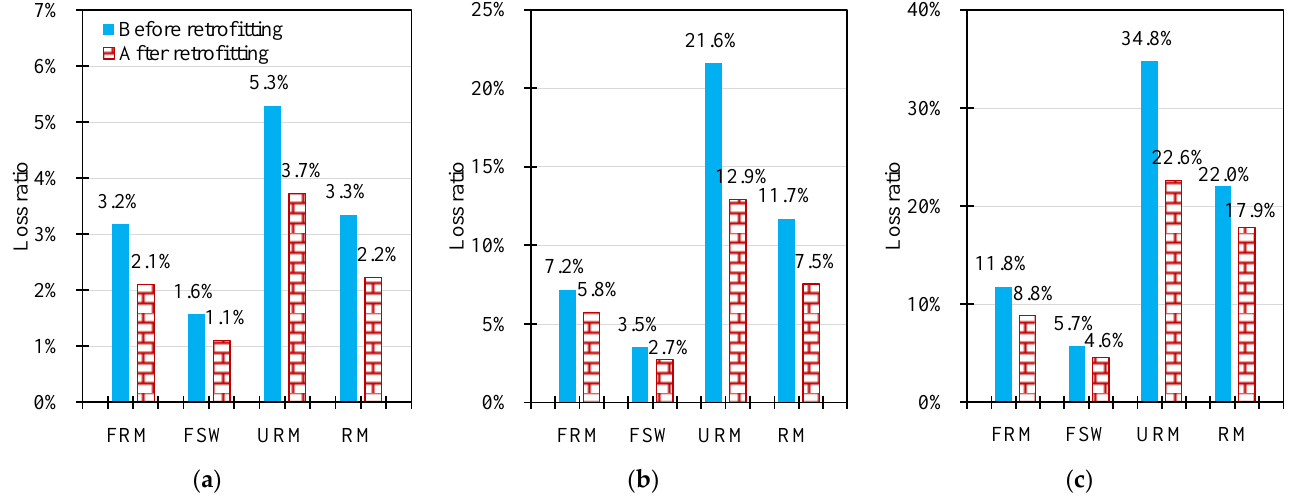
Figure 11. Seismic loss ratios of buildings of different structural types. ( a ) SLE; ( b ) DBE; ( c ) MCE.